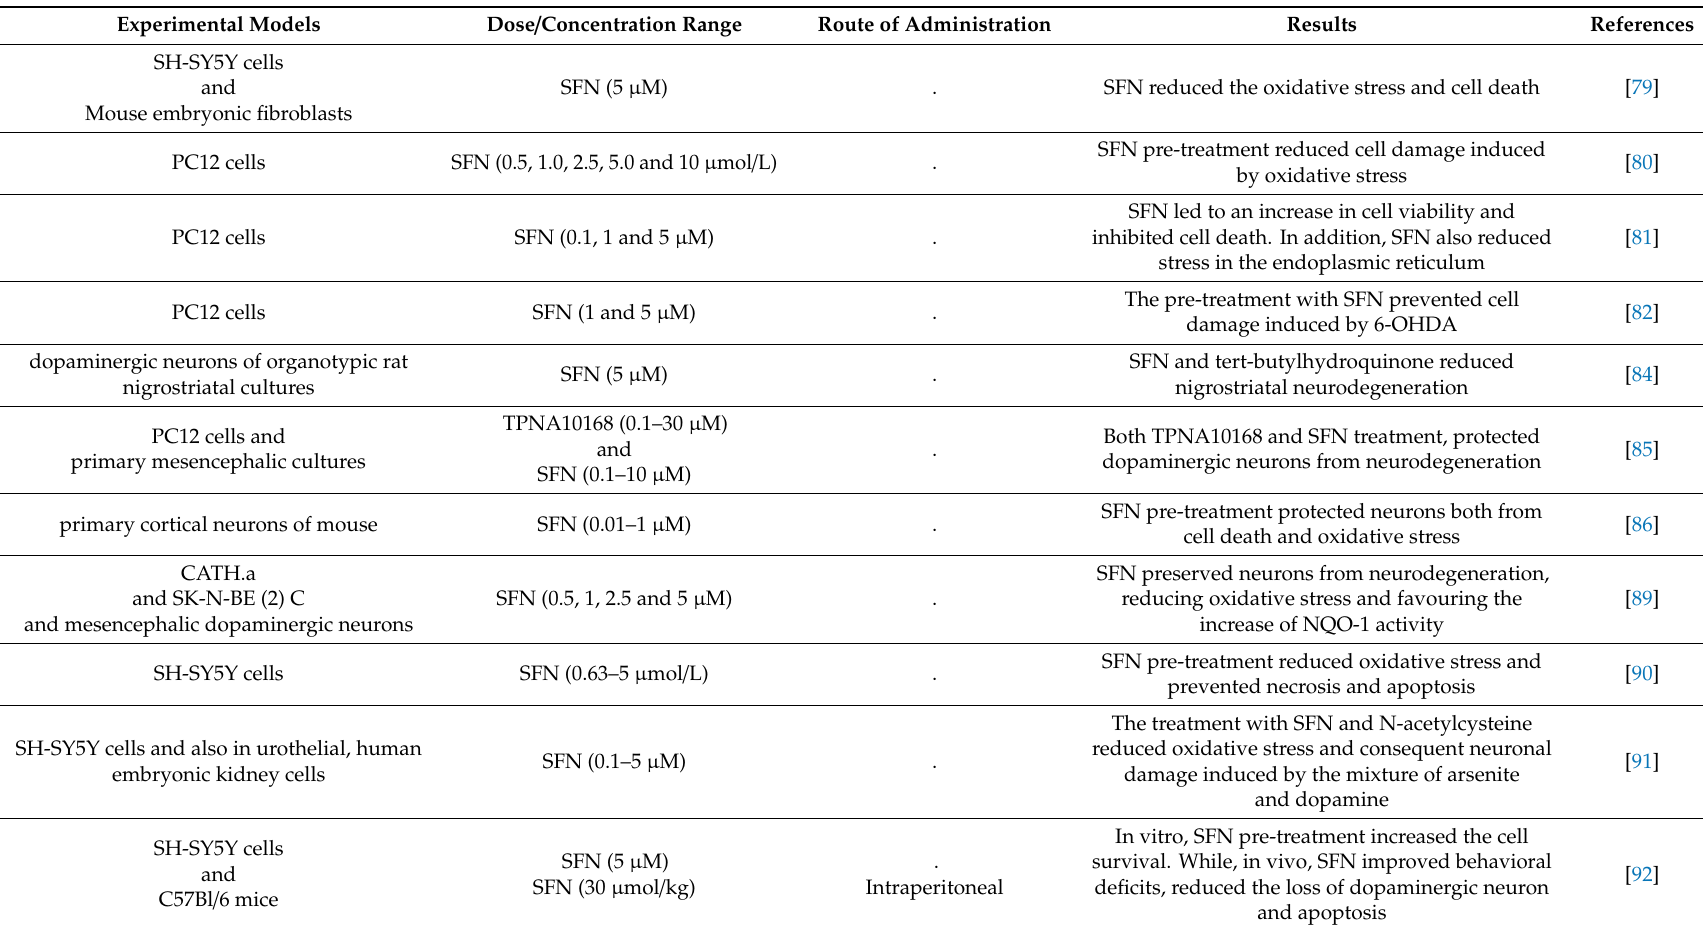
Table 3. We summarized in vitro studies that assess the e ff ects of SFN in the treatment of PD. Specifically, we described the models utilized, the dosage, the type of administration, and the